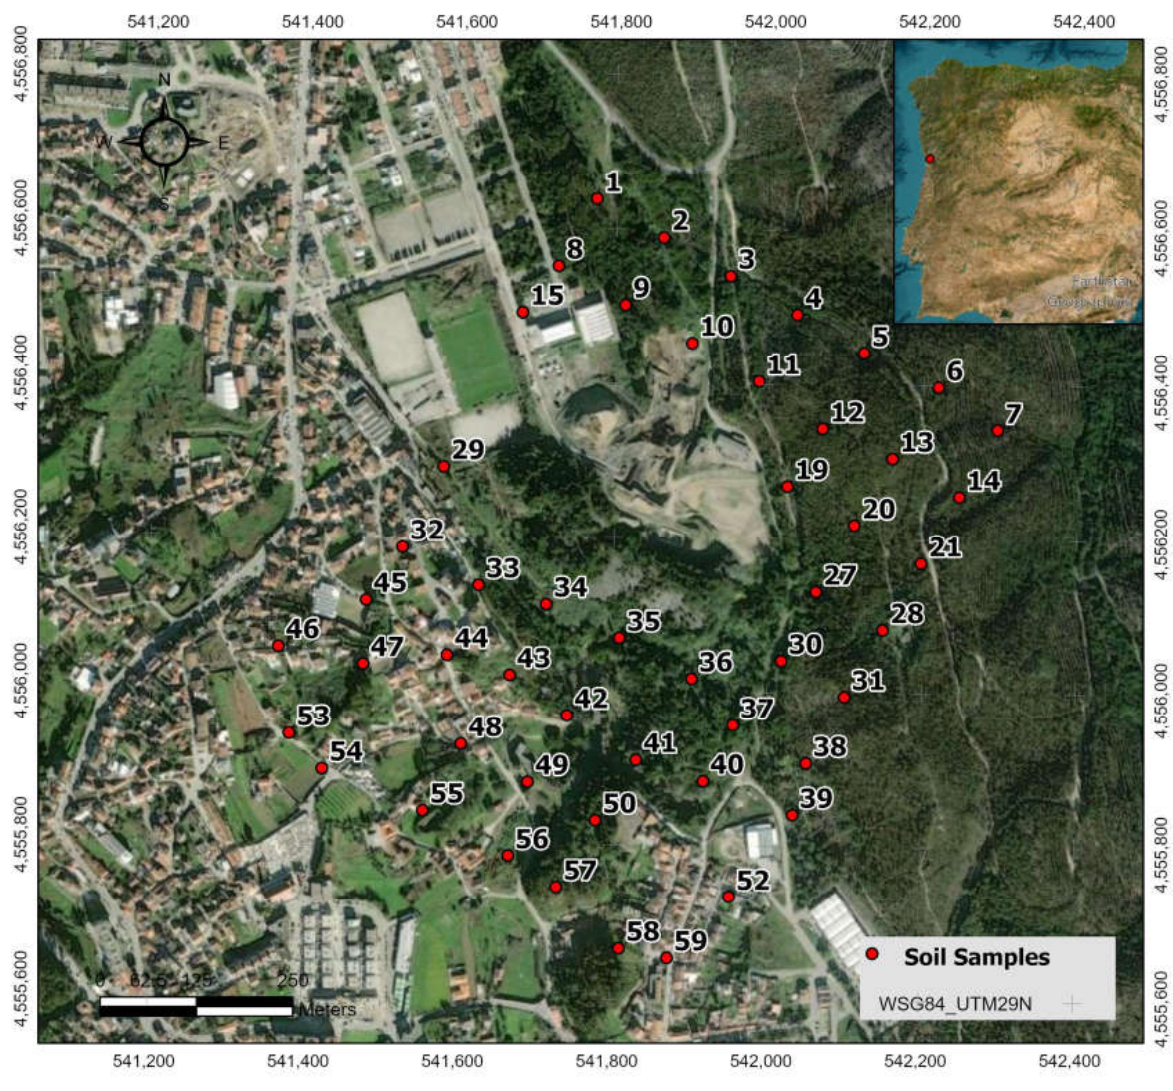
Figure 1. Soil sampling general seing.